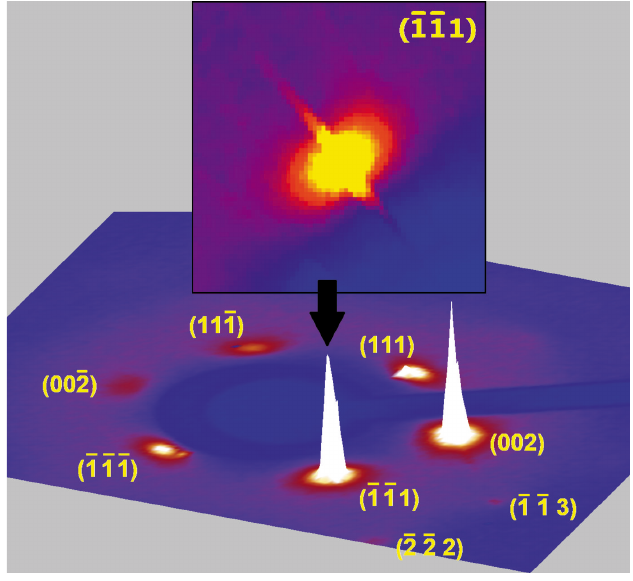
Figure 3 A single frame collected over 2 � in ! over 1800 s for the plastic phase of cyclohexane at 245 K (bottom). Only the small part of the frame containing Bragg peaks is shown. The 3D plot of the frame (CBF format) was obtained using CAP Frame View v. 1.3 (Rigaku OD, 2015). Top inset: Reflection (111) rebuilt using 183 collected frames. The projection is normal to [011], with [100] running on the right and [011] running upward. This image was generated using X-AREA (Stoe & Cie, 2019).